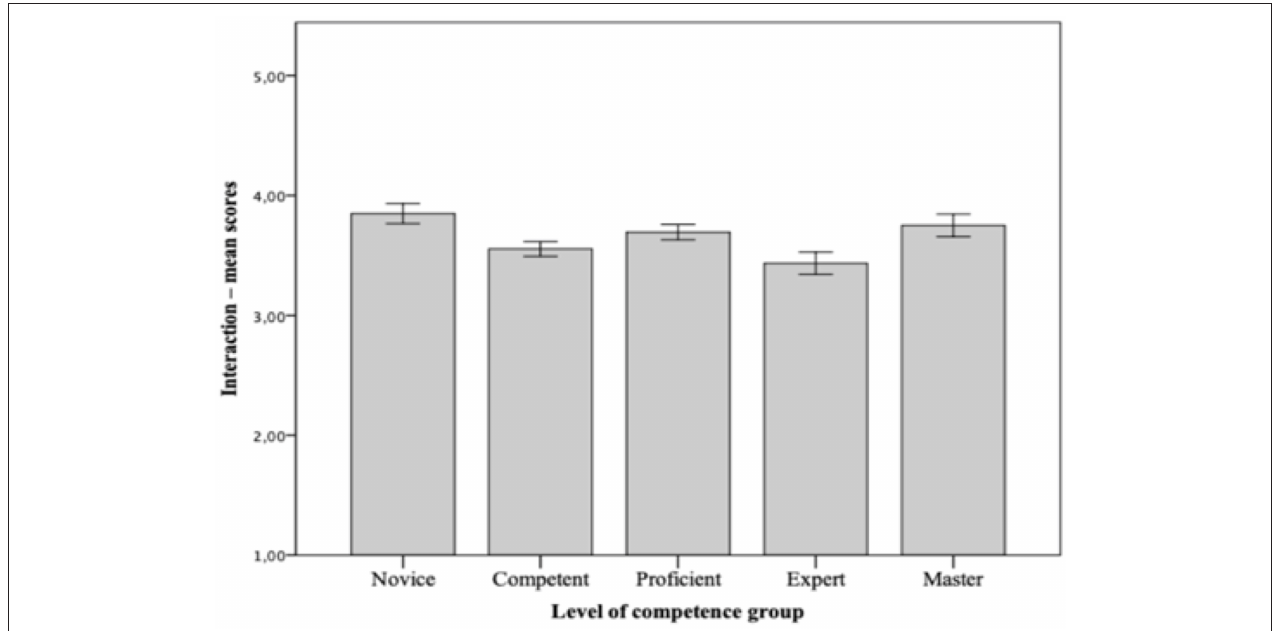
FIGURE 3 | Differences in interaction due to level of competence group. N = 907. Novice ( n = 169), competent ( n = 262), proficient ( n = 226), expert ( n = 143), master ( n = 107). Error bars: 95% confidence